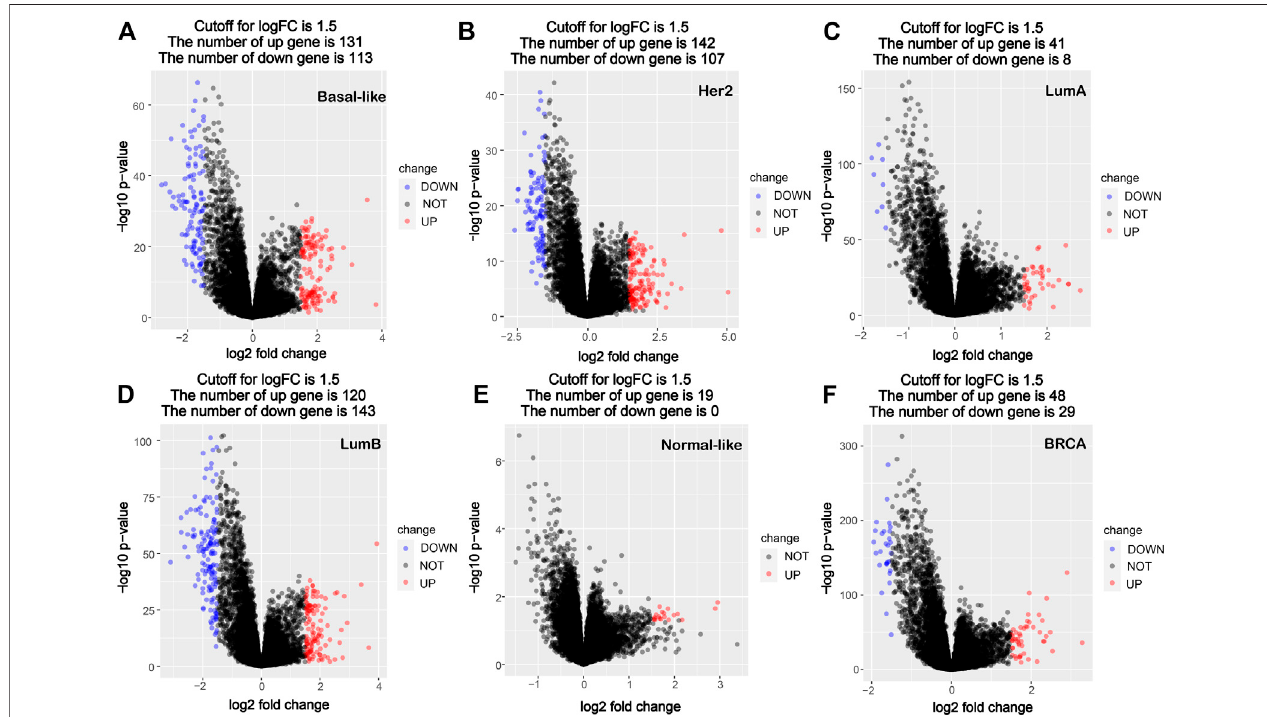
FIGURE1| VolcanomapofDEGsbetweencancertissuesandparacanceroustissuesinbreastcancermolecularsubtypesandallbreastcancer. (A) Basal-like; (B) Her2; (C) LumA; (D) LumB; (E) Normal-like; (F) BRCA (allbreast cancer). Red dots denote upregulated genes screened based on log two FC > 1.5 ( p < 0.05); blue dots denote downregulated genes screened based on log two FC < -1.5 ( p < 0.05); black dots denote genes with no signi fi cant difference ( p < 0.05). p < 0.05, FC, fold